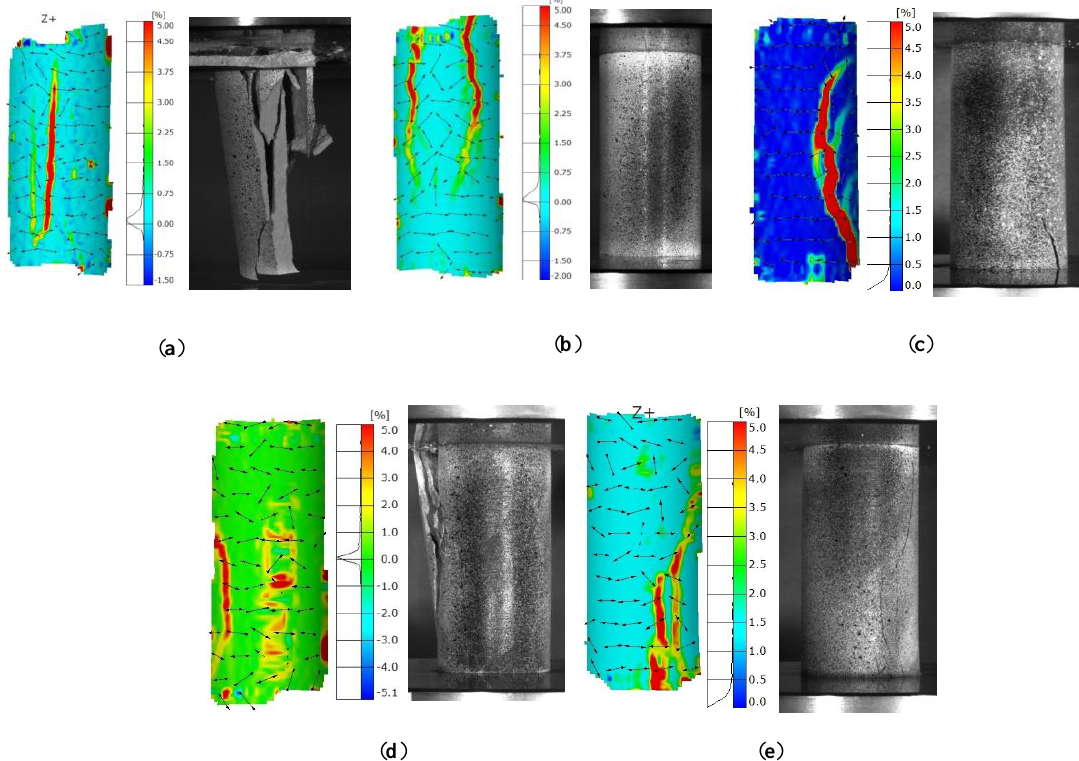
Figure 7. ARAMIS images of varyingly saturated siltstone samples; ( a ) dry, ( b ) water-saturated, ( c ) 10% NaCl-saturated, ( d ) 20% NaCl-saturated, and ( e ) 30% NaCl-saturated. Note that the colour maps indicate the sample deformation in both axial and lateral direction soon before failure.